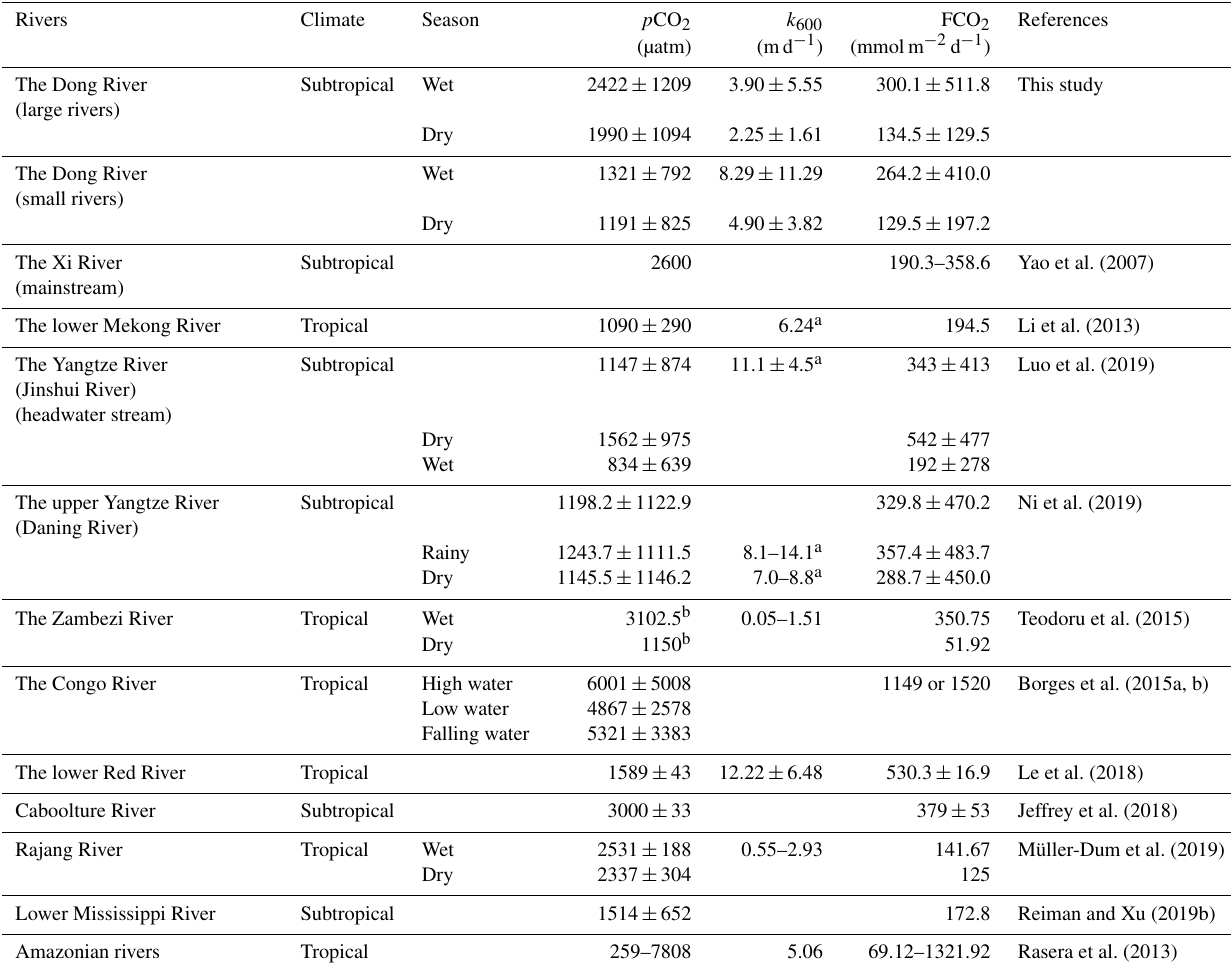
Table 3. Comparison of CO 2 emissions from subtropical and tropical